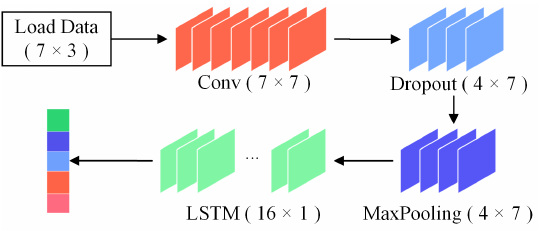
Figure 5. The CLSTM network structure.